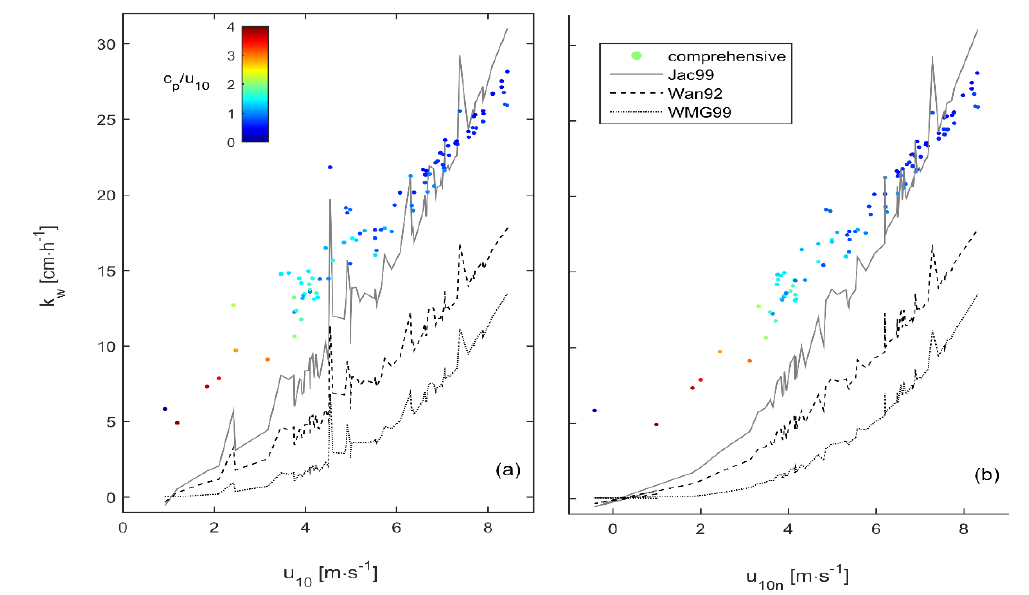
Figure 8. Comparing transfer velocities predicted by comprehensive physical-based algorithms and empirical u 10 -based algorithms. Comprehensive algorithm included k wind term by Terray et al. [53] and k bubble term by Woolf [38]. Empirical u 10 -based algorithms by Jacobs et al. (1999) [83], Wanninkhof (1992) [18] and Wanninkhof and McGillis (1999) [84]. Please confirm if the ( a ) and ( b ) should be added in this figure caption.